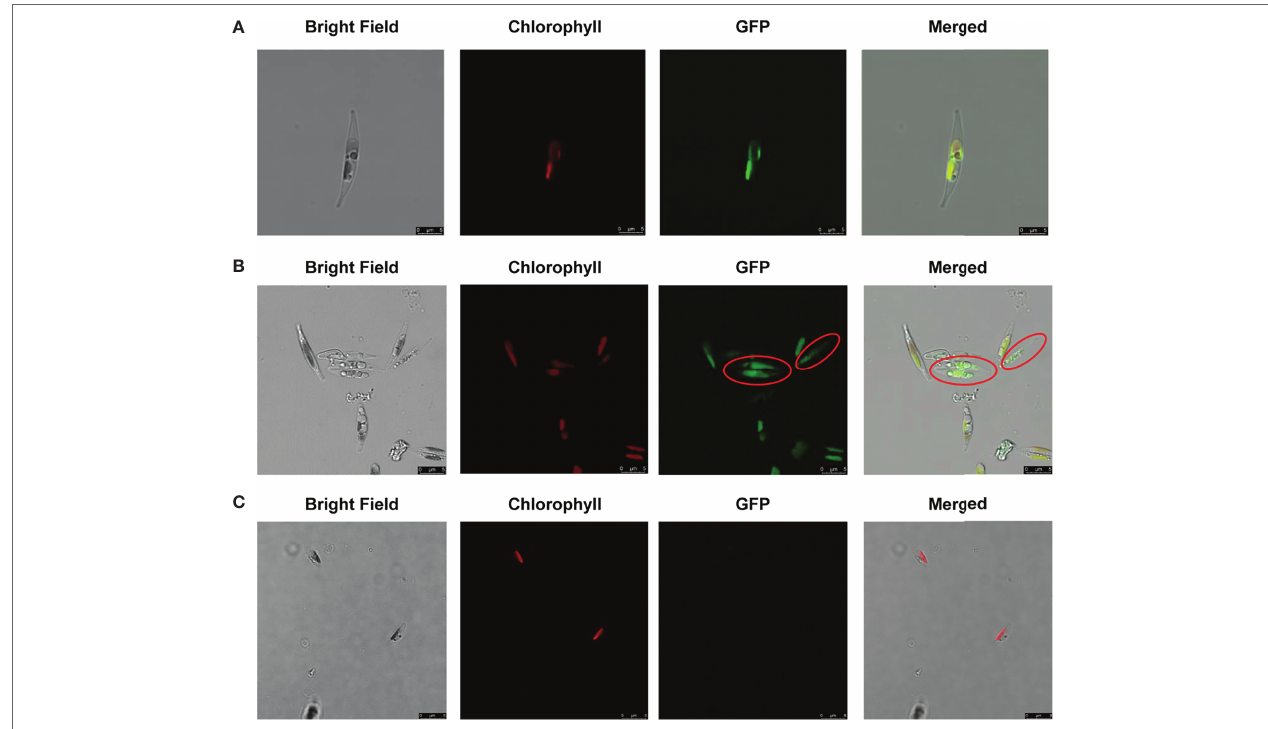
FIGURE 2 | Localization of full-length ptMGD2: eGFP fusion protein expressed in plastids (A) and cytoplasm (B) in P. tricornutum using wild type (Wt) as the negative control (C) . Bright field, light microscopical images; chlorophyll, chlorophyll auto-fluorescence; eGFP, GFP fluorescence; merged, merged channel. The scale bar represents 5 μm. Red circles indicate the cytoplasmic subcellular location.